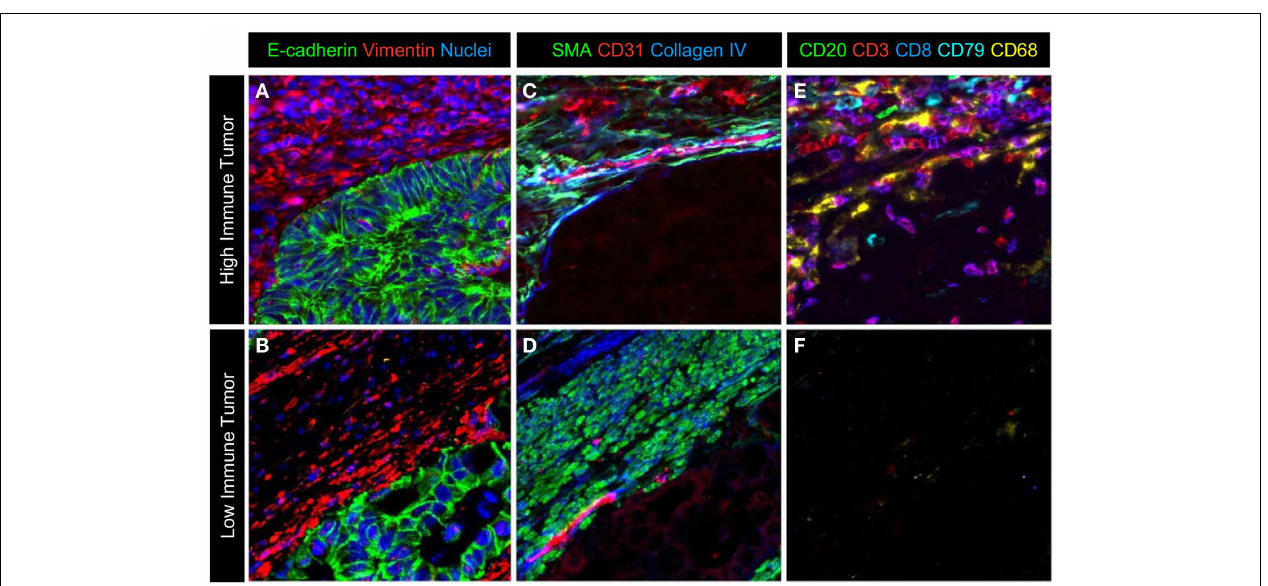
cells together with extracellular matrix protein collagen IV identifies a subset of cells and ECM structure in the adjacent tumor microenvironment. (E,F) CD20 + and CD79 + B lymphocytes, CD3 + and CD3 + /CD8 + T-lymphocytes and CD68 + macrophages are present at high levels in the stroma and infiltrating the epithelium of the tumor in (E) , while sparse immune infiltration is seen in the tumor in (F)